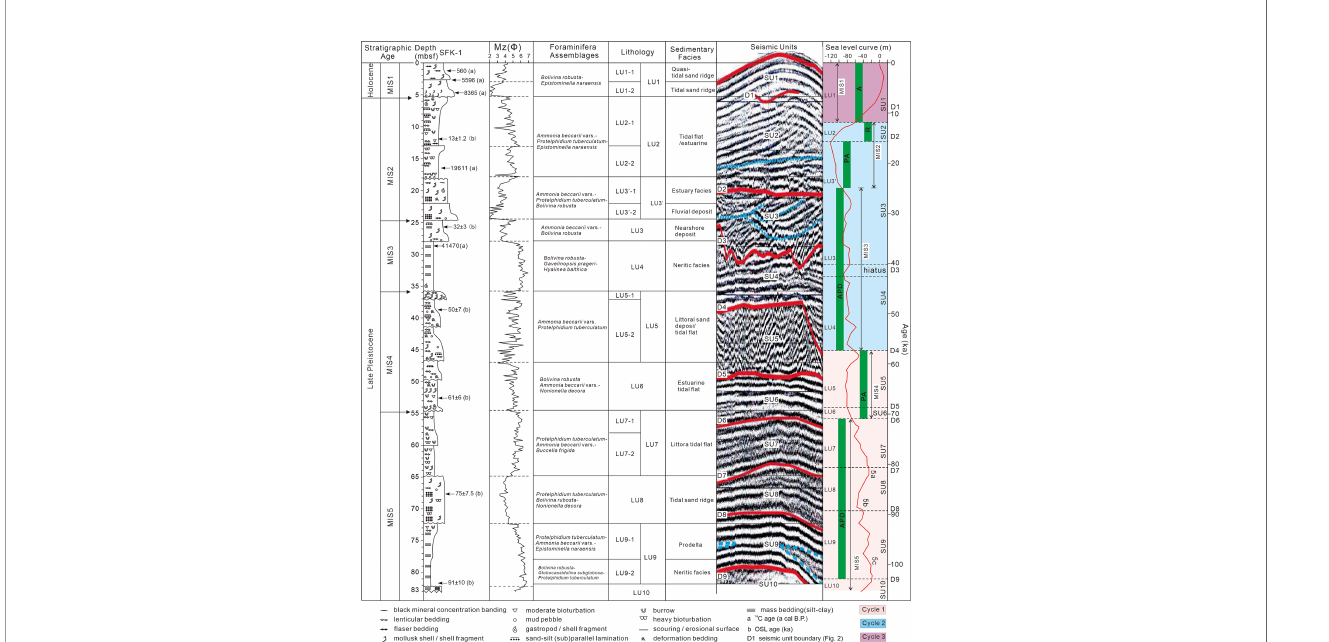
FIGURE 7 | Correlation of SFK-1lithologic units with grain size and foraminifera assemblages, seismic units and the global sea level curve. LU and SU indicates depositional units and seismic units, respectively, and D denotes the discontinuity or depositional hiatus. The sea level curve is modi fi ed from Chappell et al. (2002). Cycles 1-3 refers to the cycle of marine transgression and regression sequences. APD, PA and R indicates the stratigraphic motif of aggradation- progradation- degradation, aggradation- progradation, retrogradation proposed by Neal and Abreu